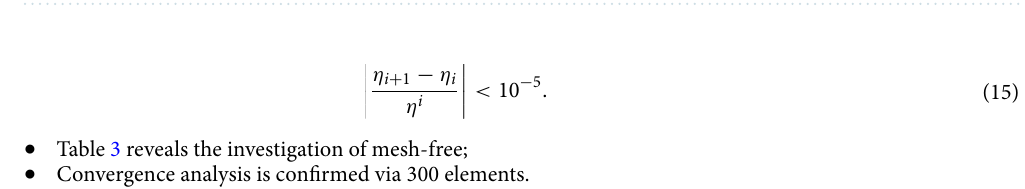
Table 5. Nanofluid properties and non-dimensional parameters as function of type and volume fraction of nanoparticles and hybrid nanoparticles.